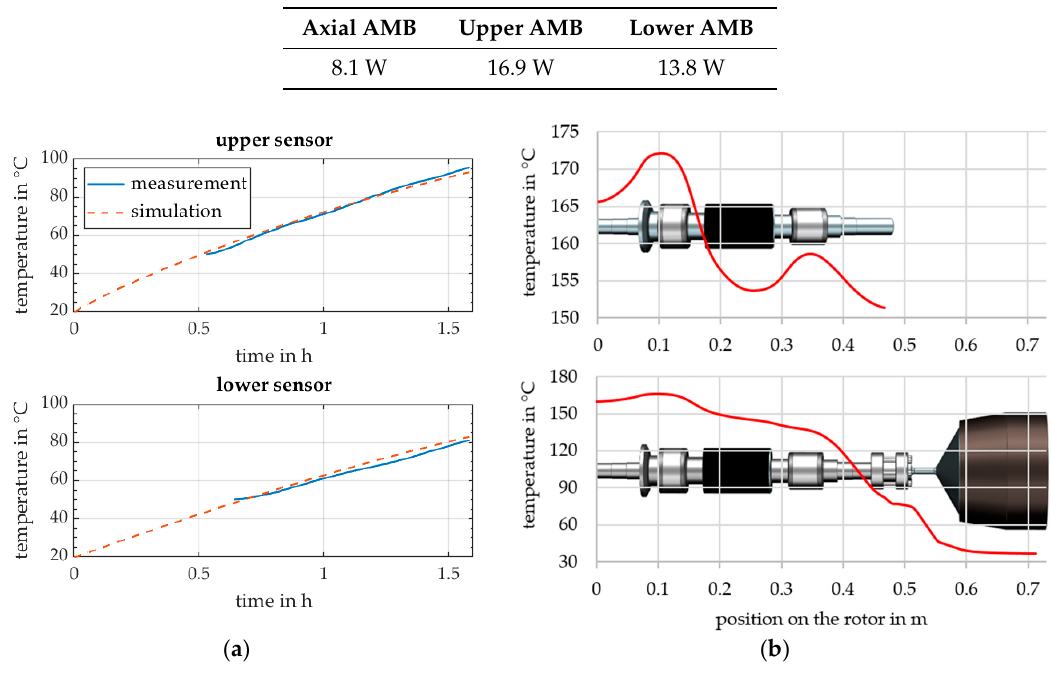
Table 3. Adjusted mean losses in the rotor during cycling.